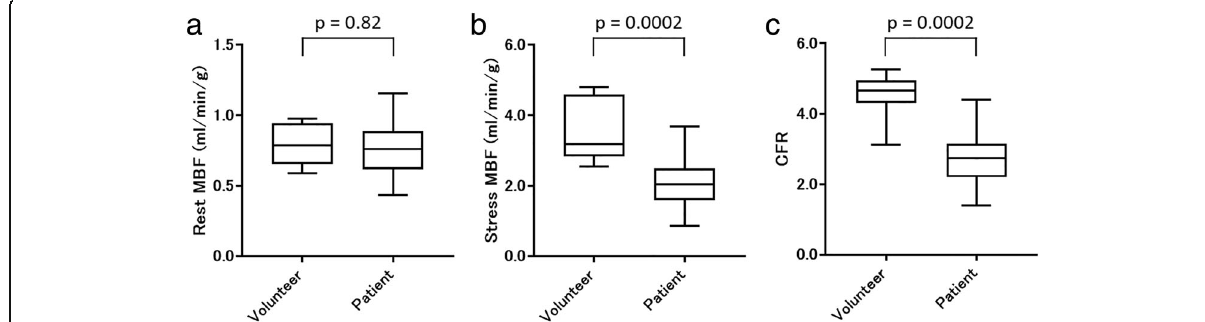
Fig. 2 Comparison of global left ventricle MBF and CFR between the volunteers and patients. Rest MBF showed no significant difference between the volunteers and patients ( a ). However, the stress MBF ( b 2.04 ± 0.62 vs 3.56 ± 0.91 ml/min/g, p = 0.0002) and whole CFR ( c 2.75 ± 0.81 vs 4.54 ± 0.66, p = 0.0002) of the volunteers were significantly higher than those of the patients